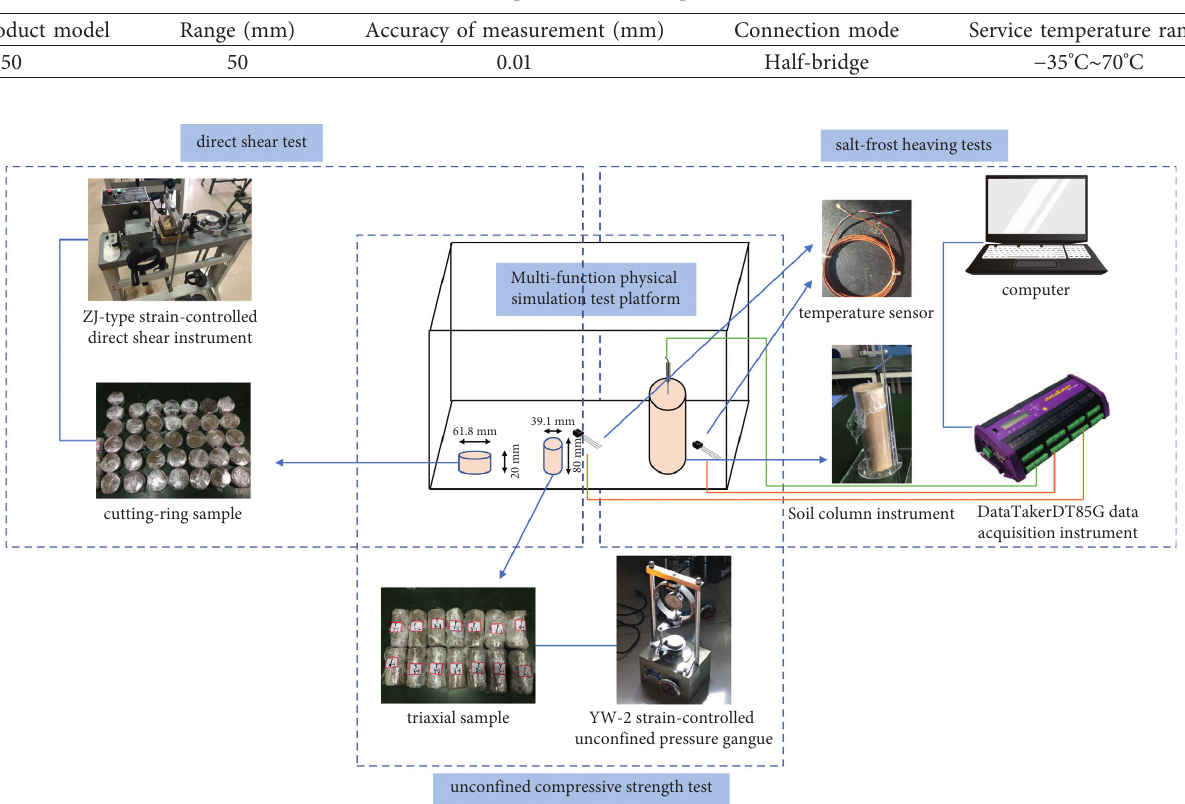
Table 5: Displacement sensor parameters.